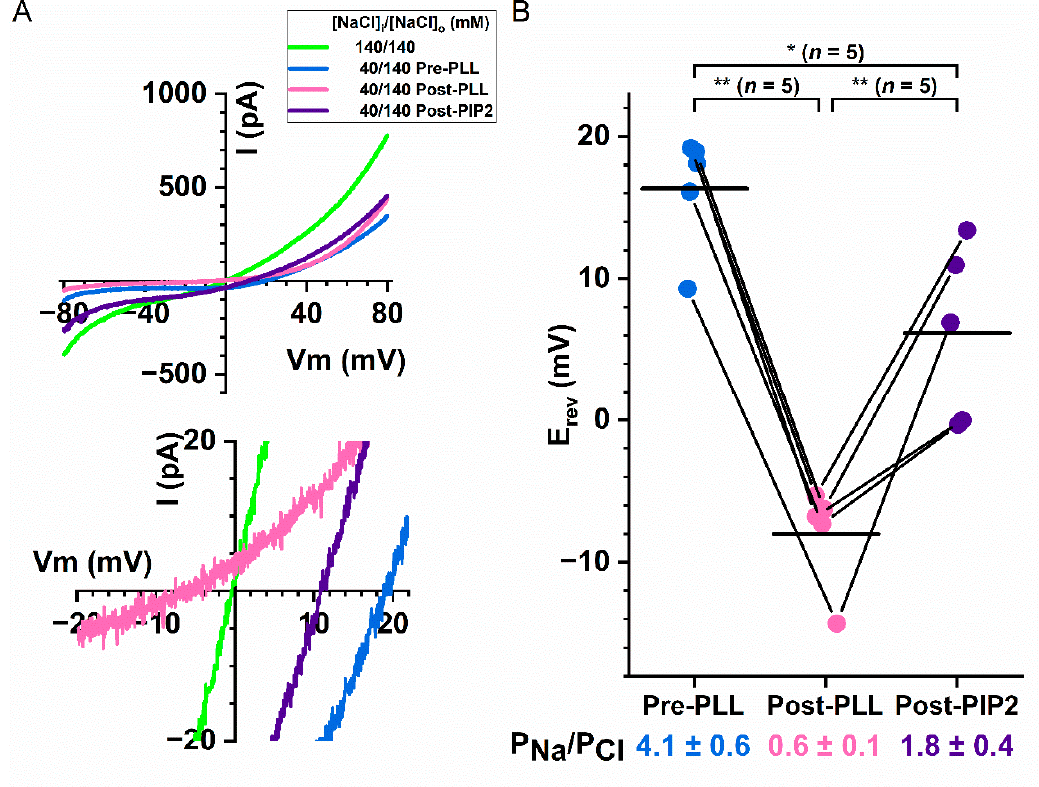
Figure 8. Effects of manipulating membrane phospholipids on the P Na /P Cl ratio of Q559W 16F . All experiments were performed with 20 µM [Ca 2+ ] i . [NaCl] o = 140 mM in all experiments. ( A ) Representative I–V curves of Q559W 16F in various intracellular solutions; − 80 mV to +80 mV are shown in the top panel, whereas the expanded traces near reversal potentials are depicted at the bottom. Experiments were first performed in 140 mM [NaCl] i (green traces), followed by experiments in 40 mM [NaCl] i before (blue traces) and after (pink traces) 0.3 mg/mL intracellular poly- L -lysine treatment for 5 sec. Finally, the I–V curve was obtained after the patch was intracellularly treated with 20 µM PIP2 for 1 min (purple traces). ( B ) Altering the P Na /P Cl ratio of Q559W 16F after treating membrane patches with intracellular poly- L -lysine or PIP2. Results are from experiments like those shown in (A) and data points from the same patch are connected by line segments. Horizontal lines depict the averaged reversal potentials from individual data set. The mean P Na /P Cl ratios (± SEM) at the bottom of the plot were calculated according to equation 1. * p < 0.05; ** p < 0.005 by one-way ANOVA followed by Bonferroni’s multiple comparisons.